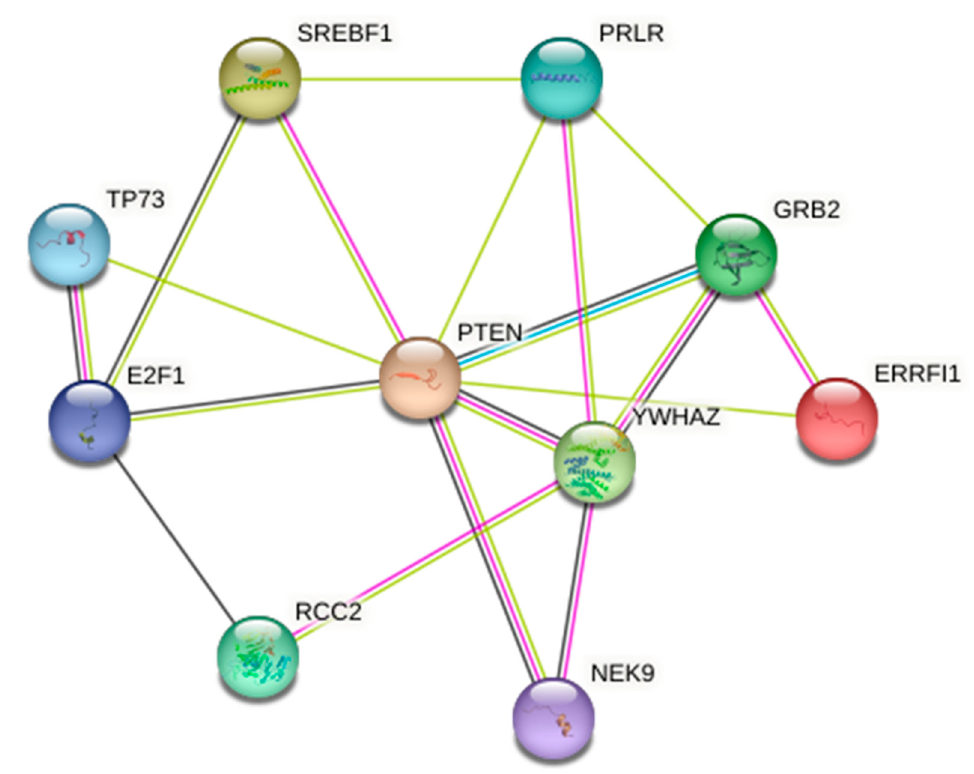
Figure 6. Protein-to-protein interaction network of proteins related to the “protein kinase binding” Gene Ontology (GO) term.